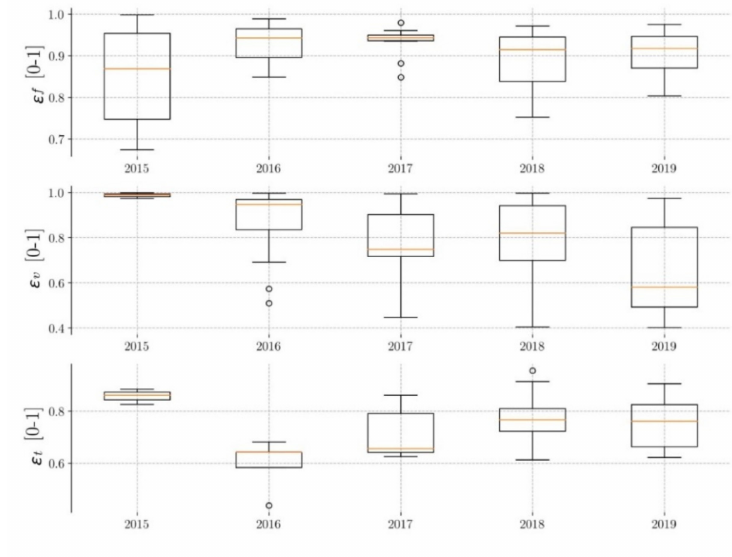
Figure 8. Evolution of pavement P3 e ffi ciency.